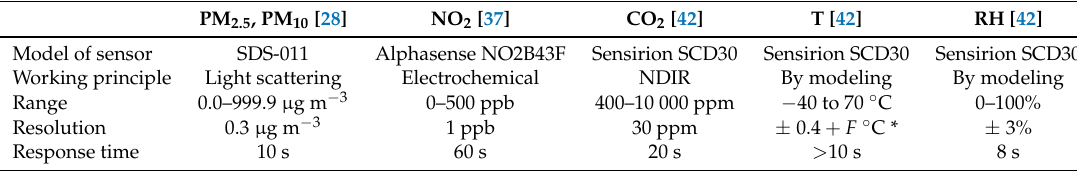
Table 1. Sensor characteristics.